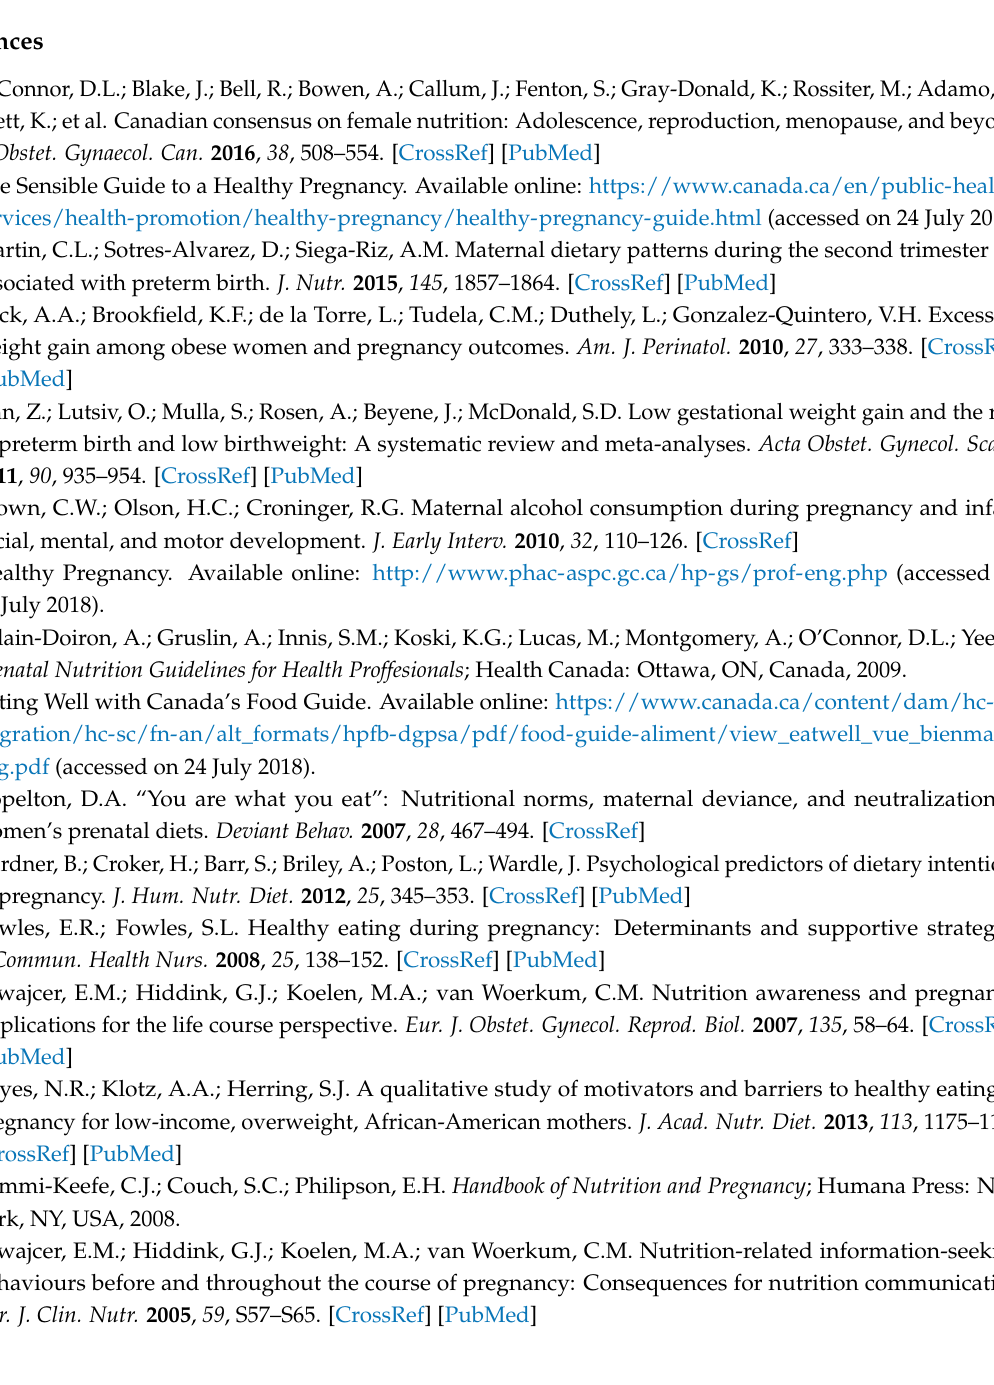
Table S1: Dietary changes made since becoming